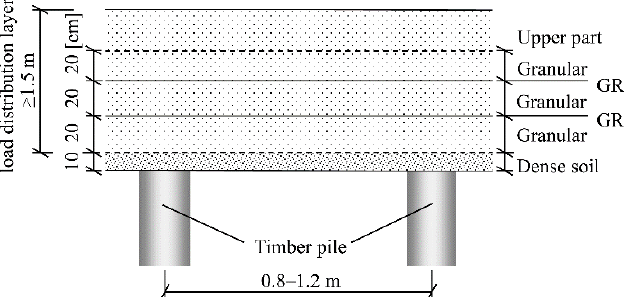
Figure 4. Embankment design criteria (vertical cross section) when using timber piles according to TK Geo 13